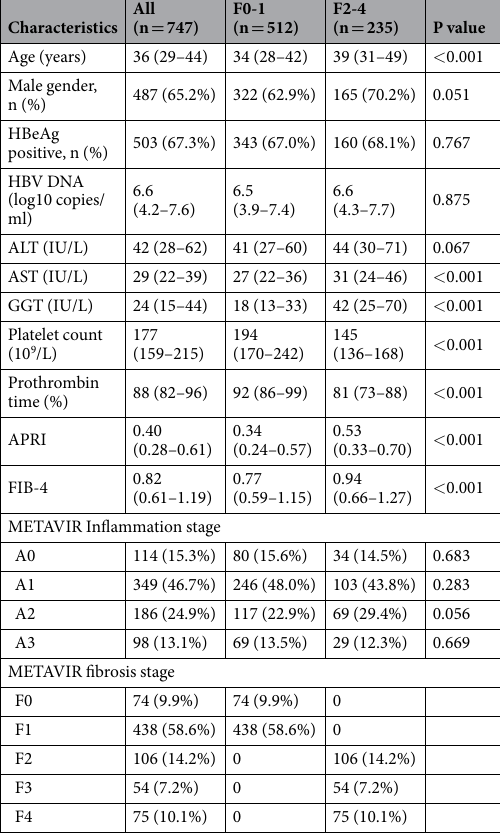
Table 1. Baseline characteristics of the study population. ALT, alanine transaminase; AST, aspartate transaminase; GGT, gamma-glutamyl transpeptidase; APRI, AST-to-platelet ratio index; FIB-4, fibrosis index based on the 4 factors; F0-1, non-advanced fibrosis; F2-4, advanced